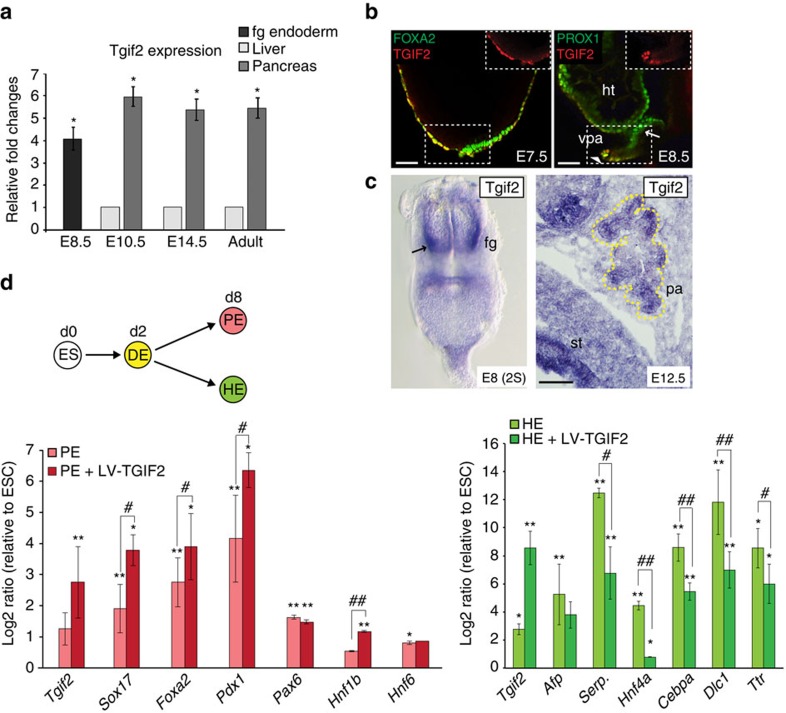
TGIF2 controls pancreatic and hepatic cell lineage divergence.(a) RT-qPCR analysis of Tgif2 expression in the mouse foregut (fg) endoderm and its derivatives, liver and pancreas. Data were normalized to that of Sdha and represented as fold change (FC) compared with liver samples (set to 1). E8.5 fg was compared with E10.5 liver sample. Values shown are mean±s.e.m. (n=3) *P<0.05. (b) TGIF2 (red) colocalizes with FOXA2 (green) in the E7.5 mouse anterior DE and with PROX1 (green) in the E8.5 at the fg lip (see arrowhead). Arrow indicates prospective hepatic endoderm (HE). Inset panels depict TGIF2 single channel image of the area in the dashed box. Embryos are presented in lateral view. Scale bars, 50 μm. ht, heart; vpa, ventral pancreas. (c) Left, whole-mount in situ hybridisation analysis of Tgif2 in 2S-stage mouse embryo. Embryo is presented in ventral view; arrow indicates lateral domains of the ventral fg. Right, in situ hybridisation on E12.5 mouse cryosections detects expression of Tgif2 in the whole pancreatic epithelium (demarcated by yellow dotted line). Scale bar, 50 μm. pa, pancreas; st, stomach. (d) Schematic showing directed differentiation of mESC cultures into DE and, subsequently, pancreatic (PE) or hepatic endoderm (HE). On day (d) 8 of differentiation, PE and HE populations were analysed by RT-qPCR for the expression of the indicated genes in the presence or absence of LV-TGIF2. Induction of endogenous Tgif2 transcript was observed during directed differentiation of ESCs toward endoderm, consistent with its expression profile in the gastrulating mouse embryo (b). Data were normalized to that of Sdha and shown as Log2-expression ratio relative to control undifferentiated ES cultures. Serp., Serpina1. Values shown are mean±s.e.m. (n=3). *P<0.05, **P<0.01 obtained with REST randomization test63 for differentiated PE or HE versus undifferentiated ESC; #P<0.05, ##P<0.01 obtained for PE or HE+LV-TGIF2 versus non-transduced PE or HE.